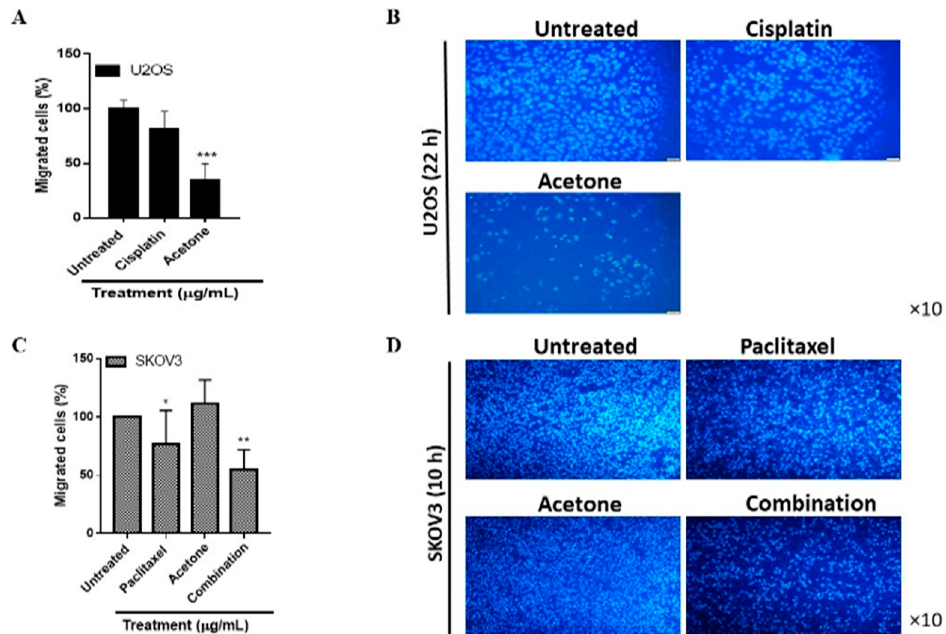
Figure 7. S. triloba acetone extract decreases U2OS cell migration. The effect of S. triloba acetone extract (IC 50 ) on U2OS and SKOV3 cell migration was determined using the transwell migration assay and images taken at 22 h and 9 h respectively. ( A ) S. triloba acetone extract significantly decreased the percentage of migrated U2OS cells by approximately 70% when compared to untreated controls; nevertheless, the cisplatin (IC 50 ) control did not significantly affect U2OS cell migration. ( B ) Representative images displaying DAPI-stained nuclei of U2OS cells that migrated to the lower chamber of the transwell insert. ( C ) On the other hand, SKOV3 cell migration was relatively unaffected after treatment with S. triloba acetone extract. However, when the acetone extract was combined with paclitaxel, SKOV3 cell migration was reduced by 42%. ( D ) Representative images displaying DAPI-stained nuclei of SKOV3 cells that migrated to the lower chamber of the transwell insert. Results are a representation of three independent experiments (*** p ≤ 0.001, ** p ≤ 0.01, * p ≤ 0.05).